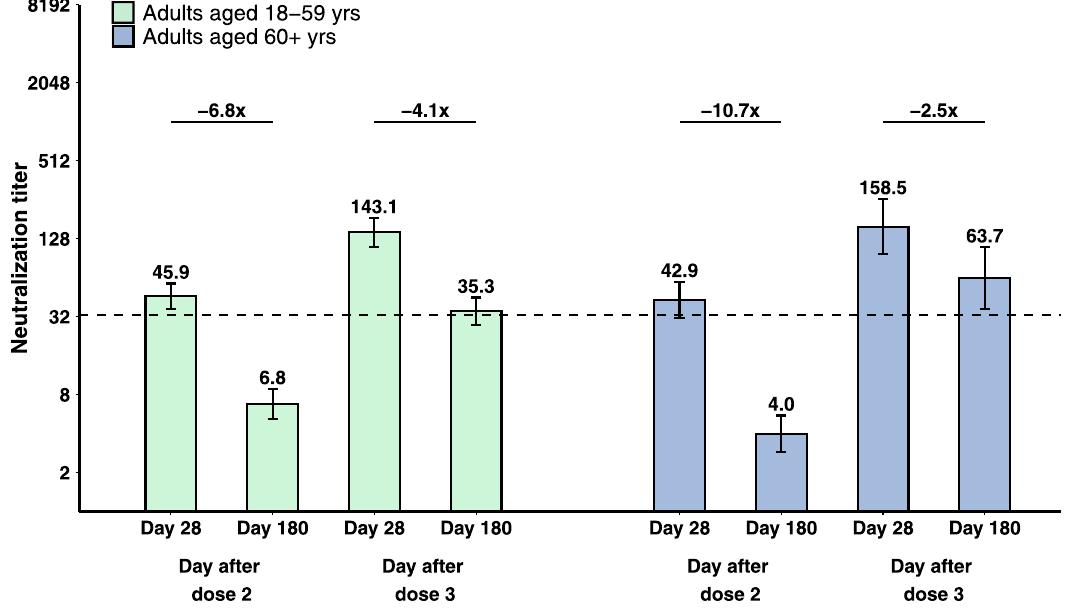
Fig. 3 Decline in neutralising antibodies to ancestral SARS-CoV-2 in 3 μ g groups in cohort 2b-28d-8m and cohort 3-28d-8m. The number of participants with paired samples for adults aged 18 – 59 (green) and adults aged 60 and over (blue) was 49 and 29, respectively. Numbers above the bars are geometric mean titres (GMTs), and error bars indicate the 95% CIs. The dotted horizontal line represents the protective threshold (1:33). Numbers above the short horizontal lines are pairwise fold-change values. GMTs and corresponding 95% CIs were calculated on the basis of standard normal distributions of log-transformed antibody titres. GMT fold decreases in neutralisation titre were calculated as ratios of paired sera at two visits. Comparisons between groups were conducted by group t tests with log-transformation (two-sided). P values of pairwise comparisons were P < 0.0001, P < 0.0001, P < 0.0001, P = 0.0187, from left to right,